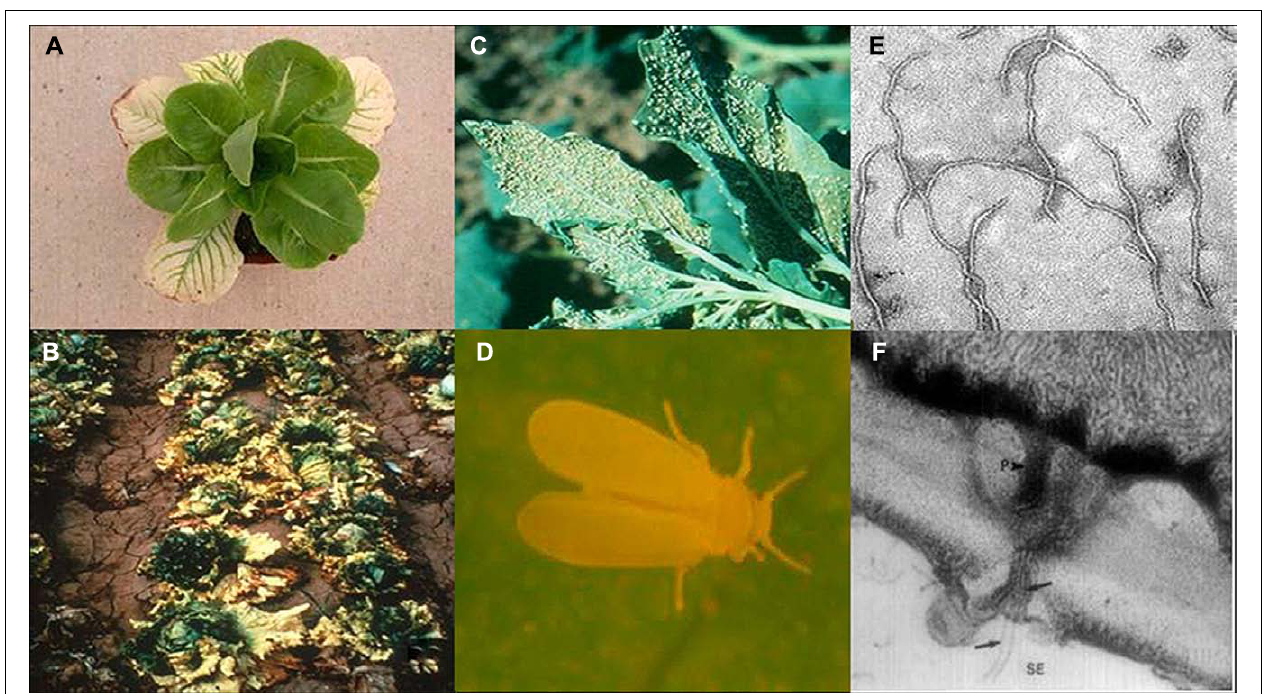
FIGURE 1 | Lettuce infectious yellows virus (LIYV) infected lettuce plants close up (A) and field shot (B) .The sweetpotato whitefly, Bemisia tabaci NewWorld (formerly called biotype A) colonizing a Chenopodium spp. plant in the field (C) and close up (D) . LIYV virions by transmission electron microscopy (E) and (F) a thin section showing cross section of